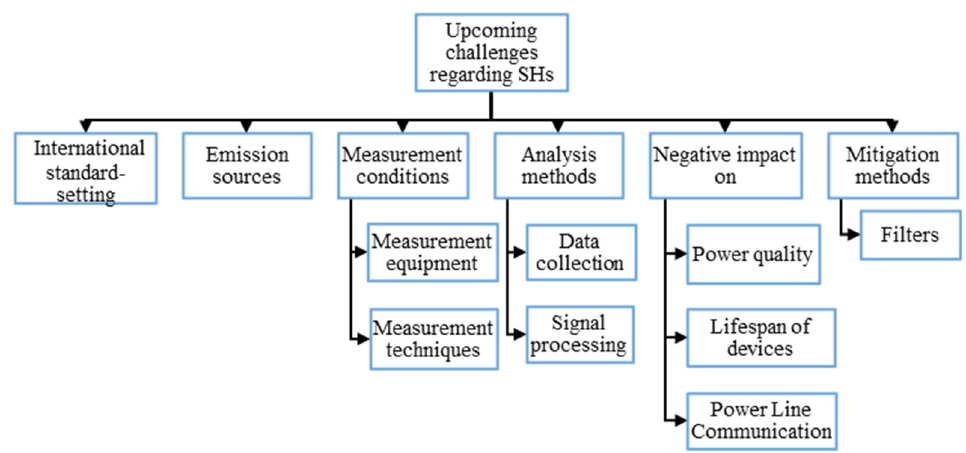
Figure 4. Upcoming challenges regarding supraharmonics domain.